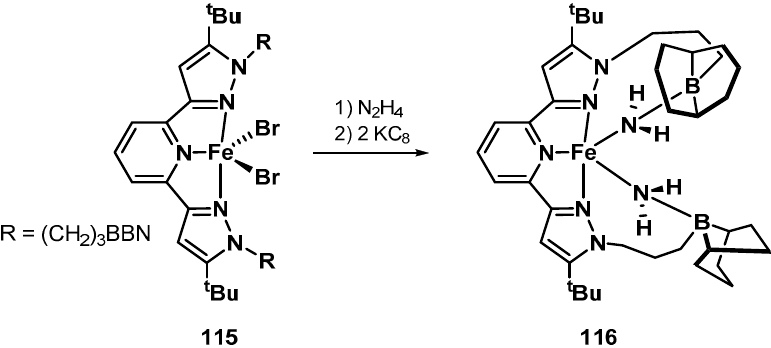
Figure 7. Szymczak’s Fe(II)-NNN pincer complex 115 coordinates one to two equivalents of hydrazine [722]. hydrazine